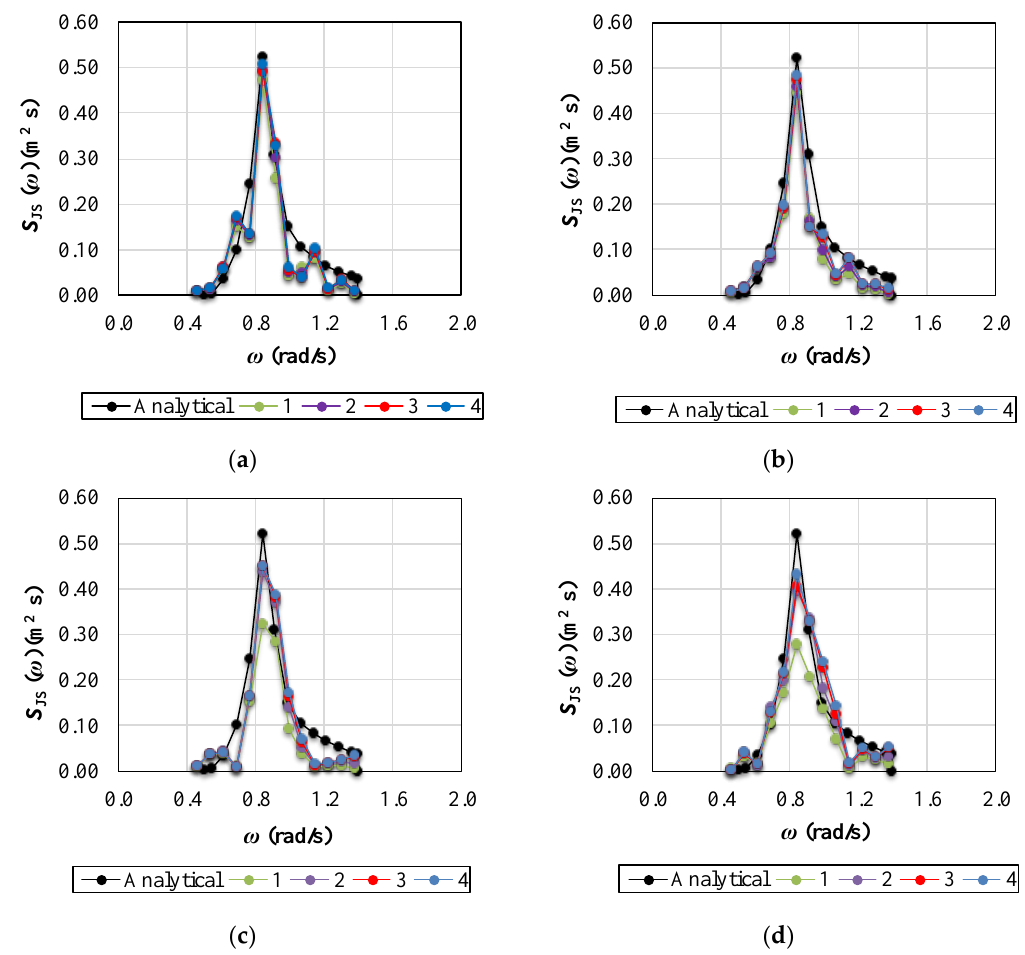
Figure 10. Spectral density for the four meshes considered from the gauges: ( a ) S1 = 50 m; ( b ) S2 = 100 m; ( c ) S3 = 150 m; and ( d ) S4 = 200 m.